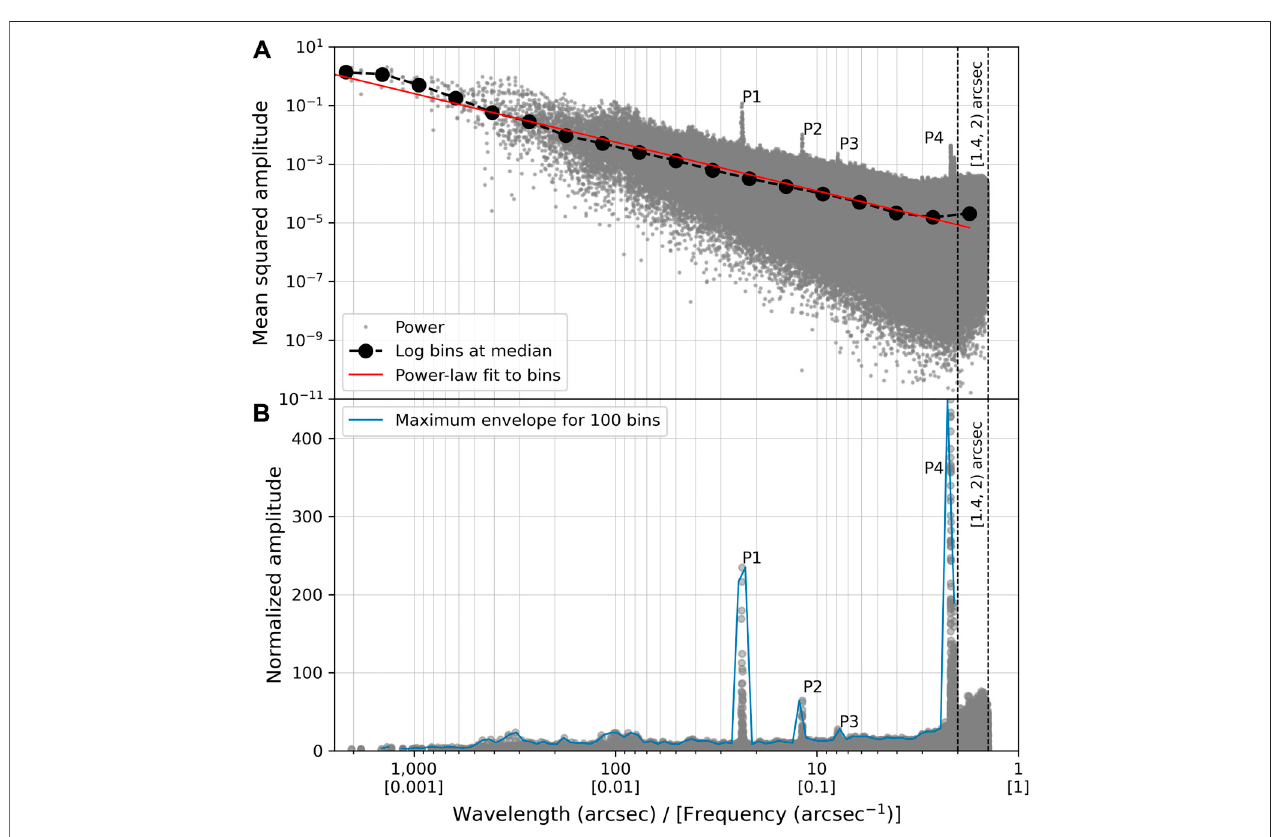
FIGURE 5 | Example of a 1D DFT normalization procedure for the same 1 arcsec ∼ 60-km square SRTM-NASADEM tile shown in Figure 4A Mean-squared amplitude (a measure of spectral power provided by the P DFT in Eq. 5 ) of HPHS (unitless) with log-spaced frequency bins and power-law fi t to the bin medians. (B) Amplitude (power) normalized by the power-law fi t, with a maximum envelope connected in 100 log-spaced frequency bins ≥ 2-arcsec wavelengths. The high-frequency power (adjacent pixels) returned by the radial frequency (cf. Eq. 4 ) are indicated by the dashed vertical lines from 1.4- to < 2-arcsec wavelengths. The peaks (P1 – 4) shown in Figure 4C are